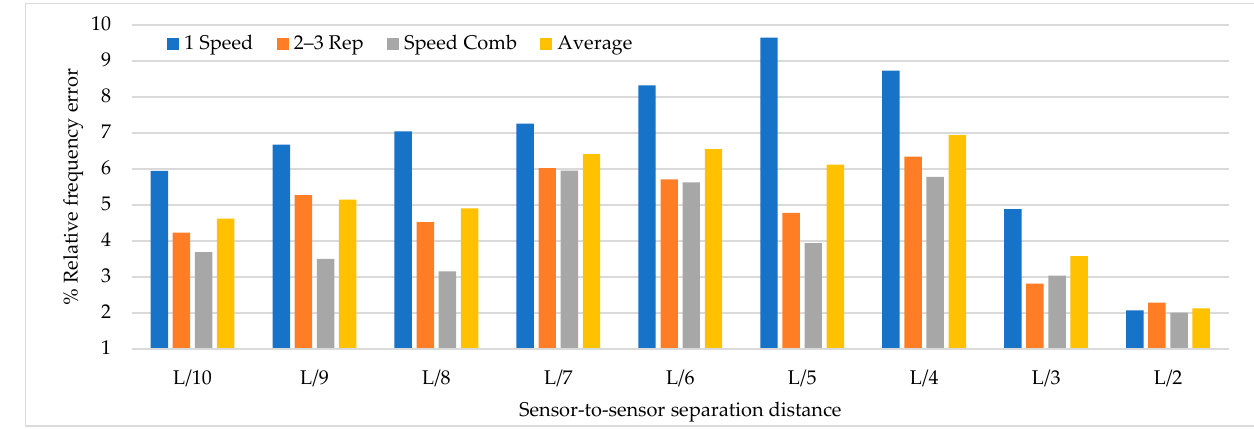
Figure 7. Percentage of relative frequency error for different sensor-to-sensor separation distances.